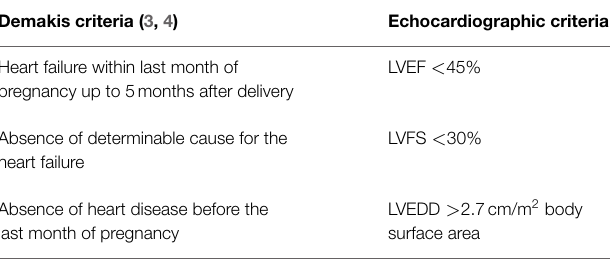
TABLE 1 | Diagnostic criteria for peripartum cardiomyopathy . Demakis criteria (3, 4) Echocardiographic